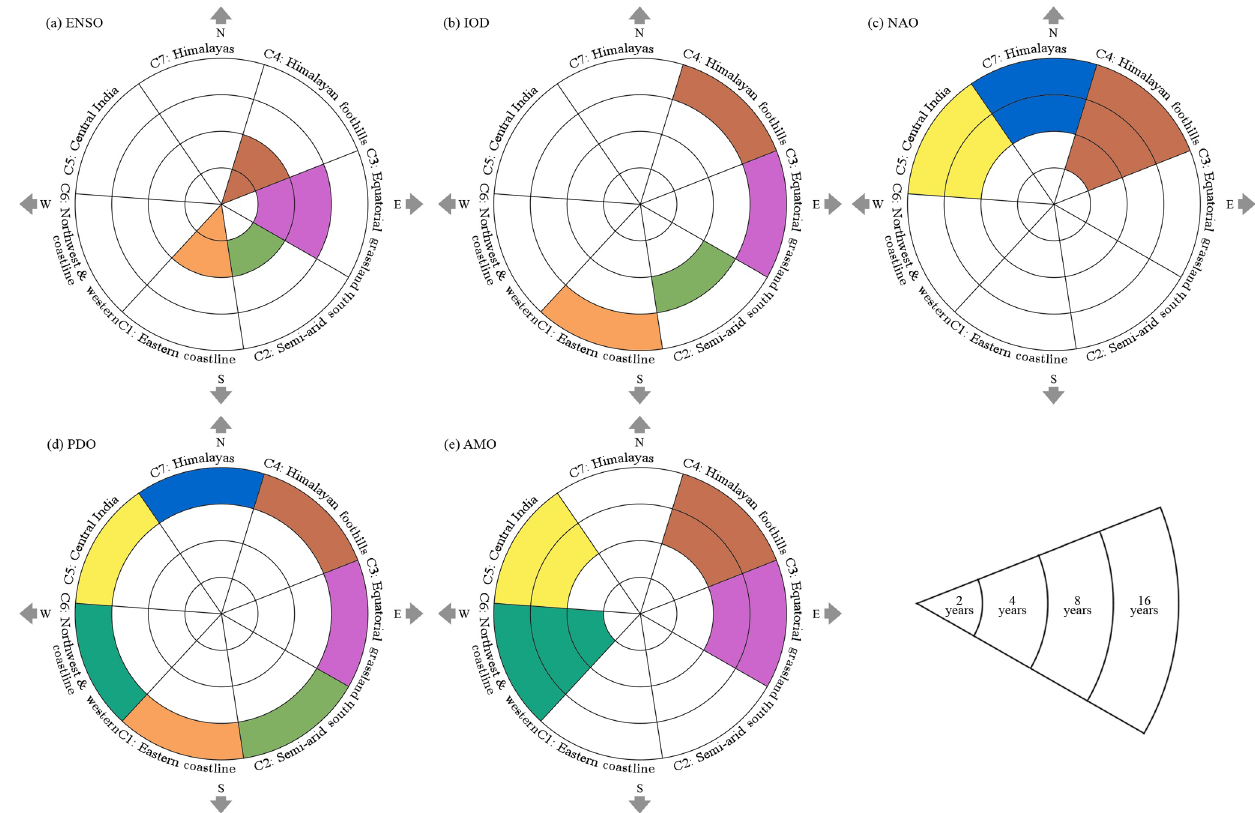
Figure 7. Schematic map of spatial diversity of Indian precipitation teleconnections at different timescales. (a) Niño 3.4, (b) IOD, (c) NAO, (d) PDO, and (e) AMO. Colours are consistent with the community shown in Fig. 4. Presence of colour (irrespective of magnitude of synchronization) in the community segment indicates significant synchronization between teleconnection and Indian precipitation. Every single segment of circle shows the temporal scale. The cardinal direction has been projected in the background of each